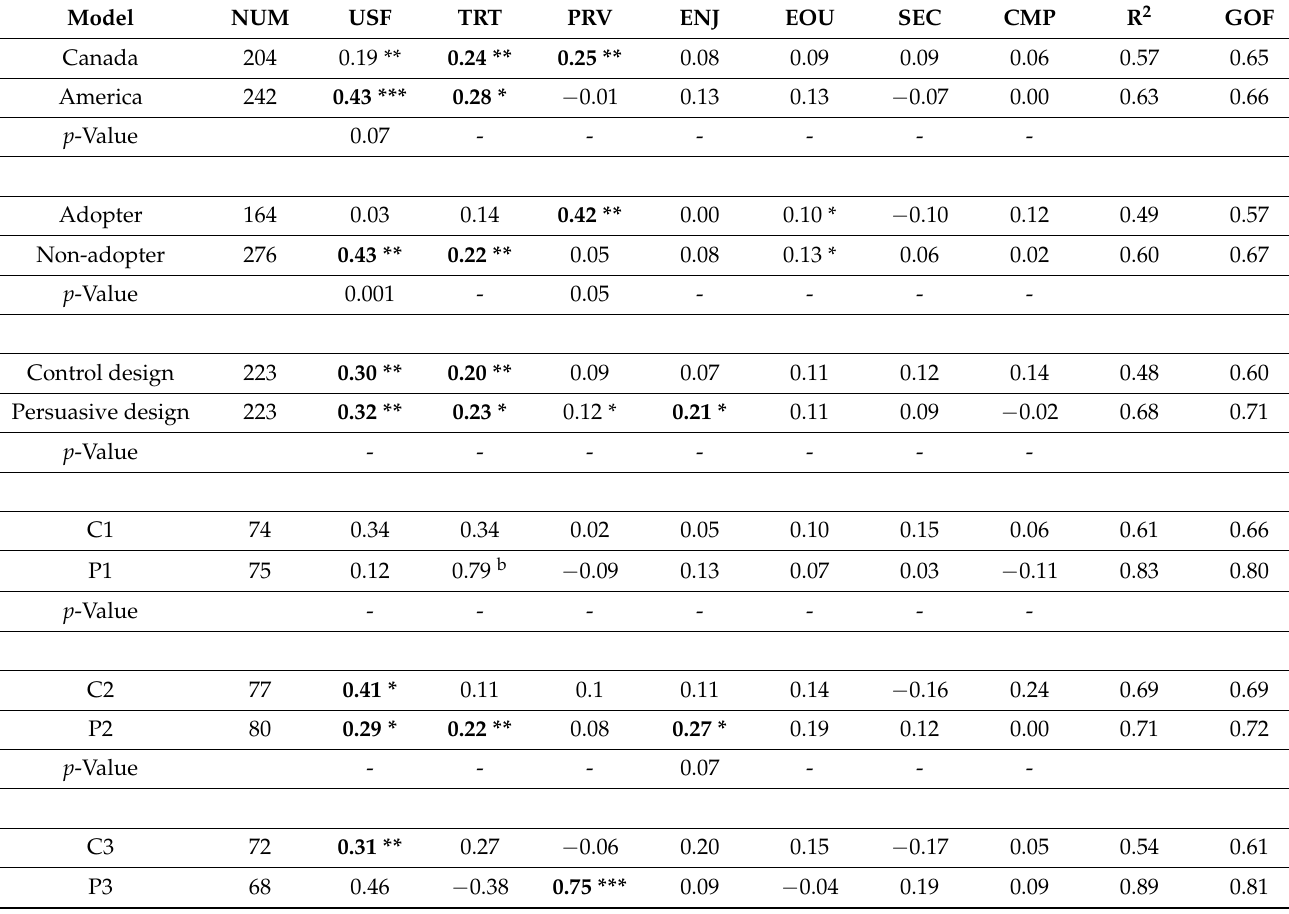
Table 3. Submodels based on country of residence, adoption status, and persuasive